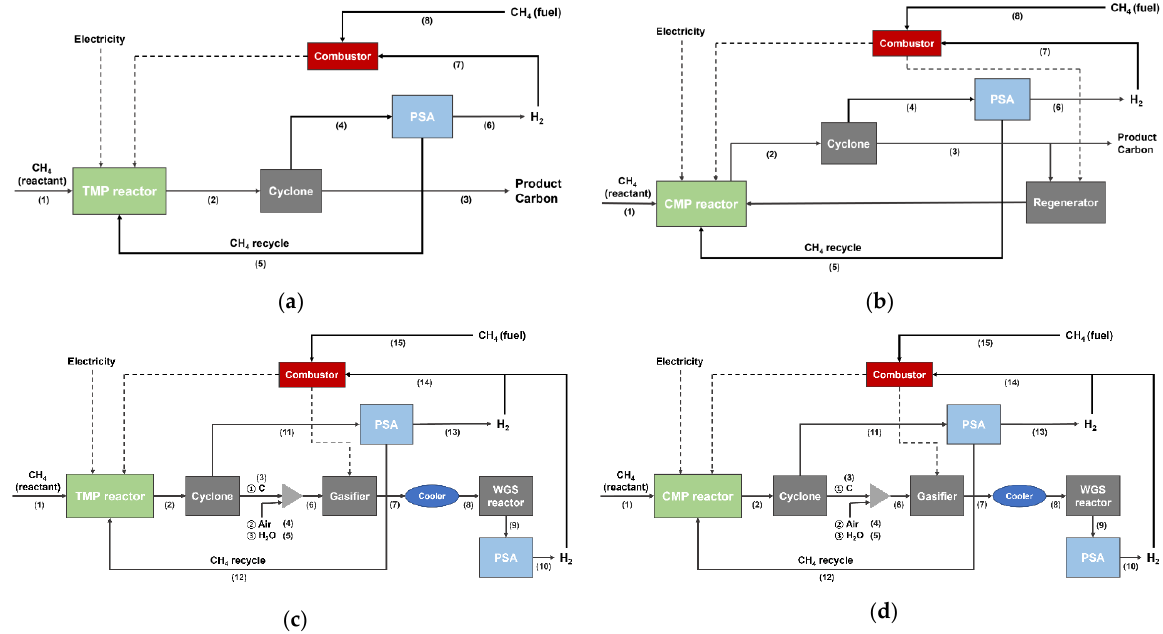
Figure 2. Results of kinetic validation for ( a ) thermal methane pyrolysis (TMP) and ( b ) catalytic methane pyrolysis (CMP) reactions.